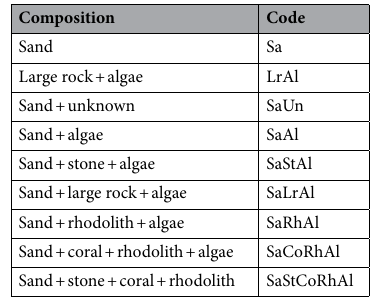
Table 1. Sediment composition description and code.